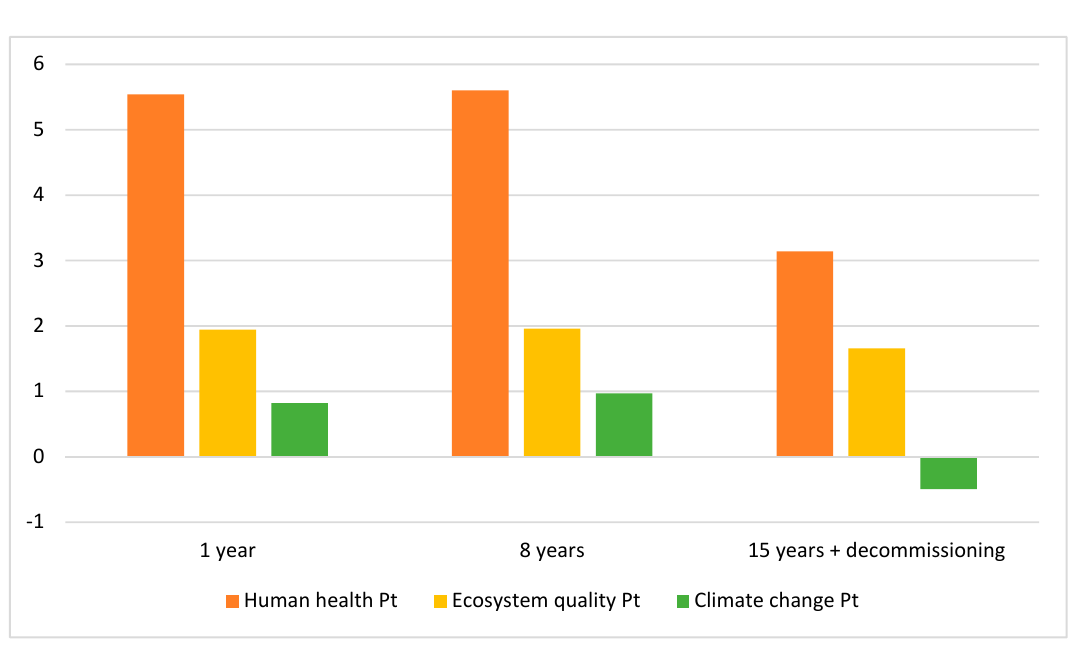
Figure 5. Damage assessment and characterization for Stirling cycle ‐ based HP.